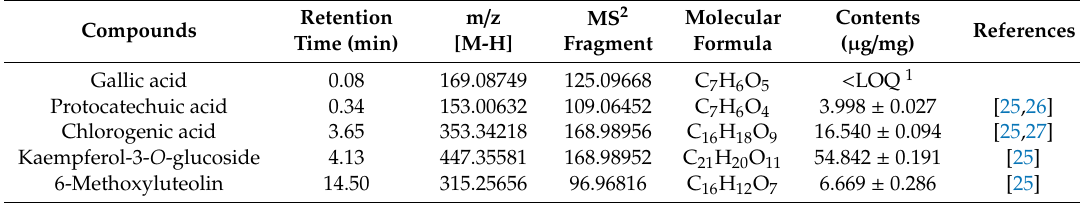
Table 1. Ultra-performance liquid chromatography-electrospray ionization-Q / Orbitrap tandem mass spectrometry analysis of Inula britannica flower aqueous